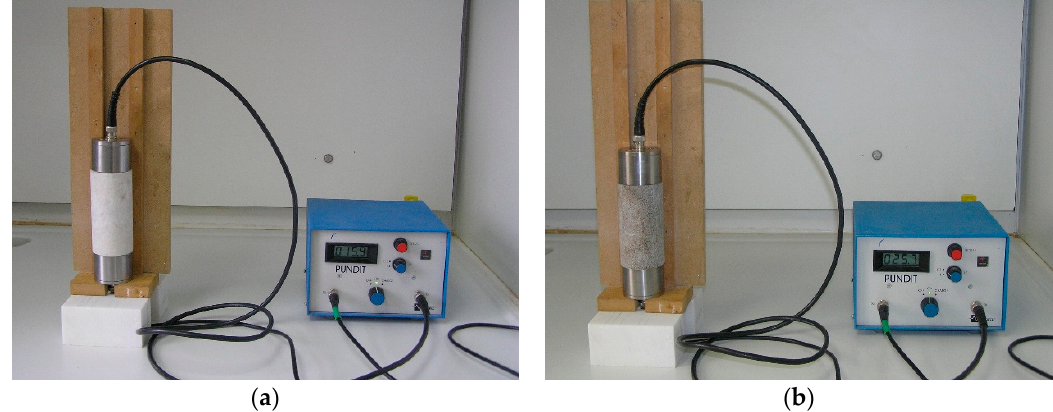
Figure 2. P-wave velocity test for ( a ) marble and ( b ) metasandstone.